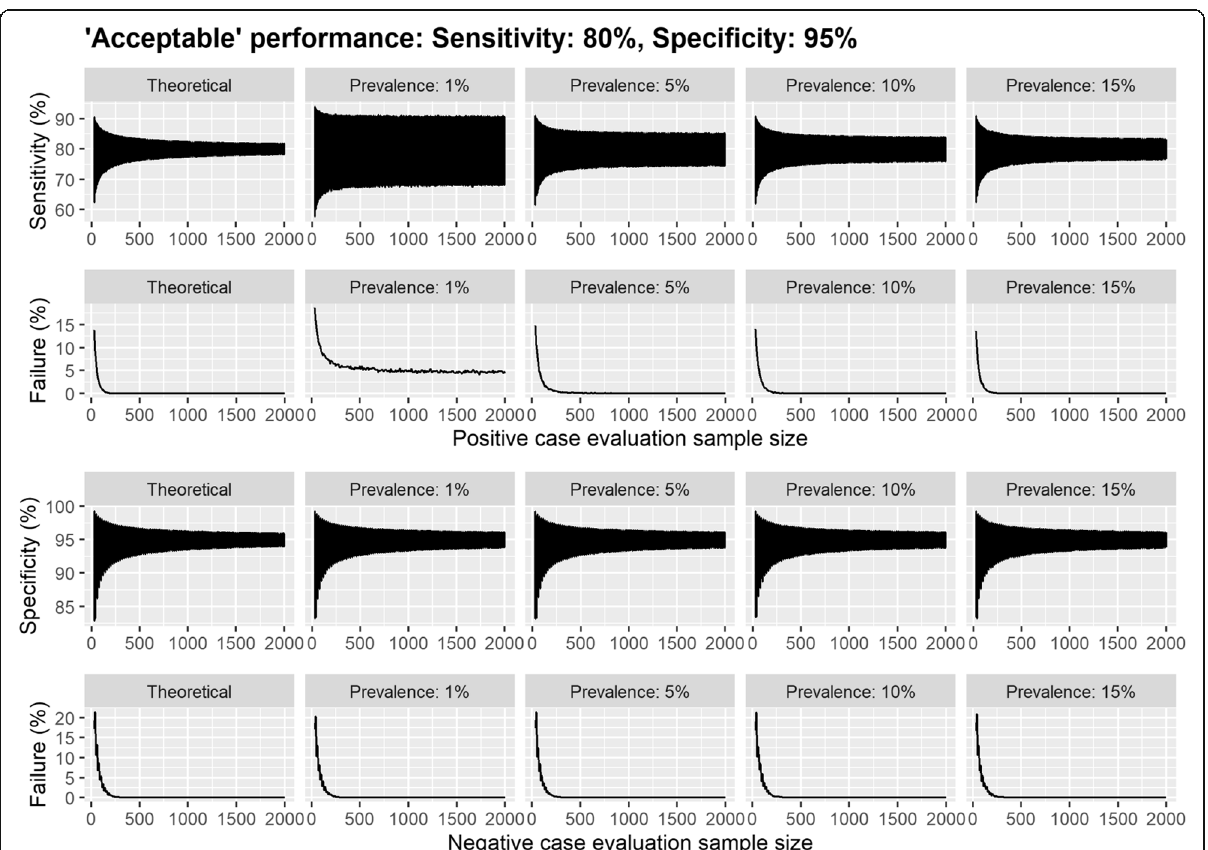
Fig. 3 A min scenario estimates of diagnostic performance from a series of Monte Carlo simulations per evaluation sample size. Each simulation consisted of 10,000 iterations each consisting of 5,000 individuals. Here, the diagnostic test was assumed to be greater than or equal to the minimum performance for the acceptable MHRA TPP with 80% sensitivity and 95% specificity in the evaluation sample. The 95% confidence intervals are displayed for sensitivity and specificity per initial evaluation sample size across different prevalence scenarios. The simulation was considered to have met the TPP confidence interval criterion if the diagnostic characteristic was above the lower bound of the 95% CI specified in the TPP (70% sensitivity and 90%